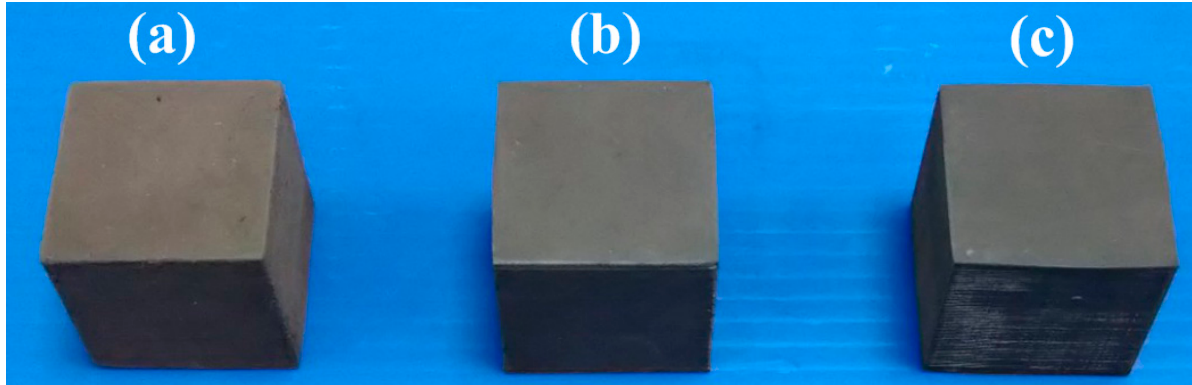
Figure 7. Specimens made with recipes ( a ) 6, ( b ) 4, and ( c ) 2.